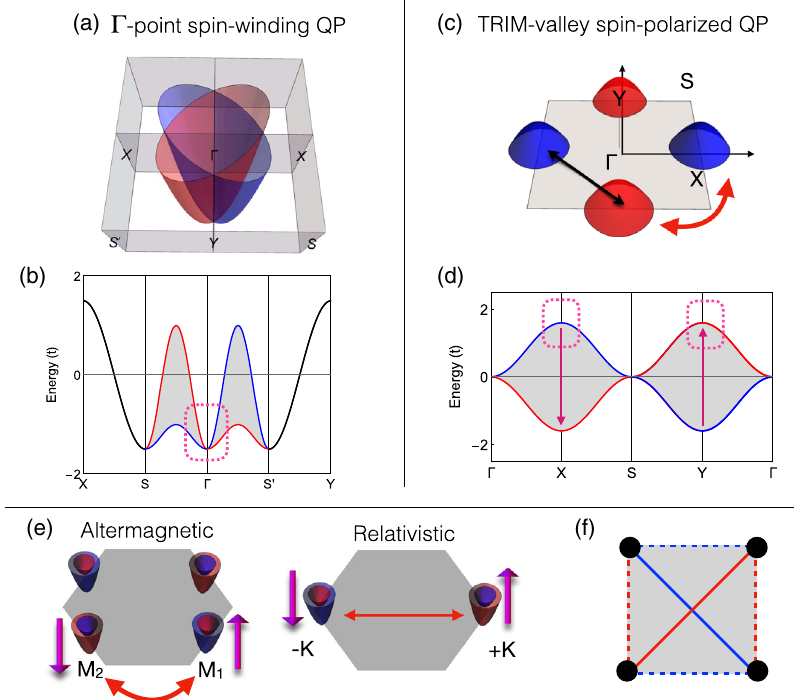
FIG. 11. (a,b) Model of the altermagnetic quasiparticle with quadratic dispersion around the spin-degenerate Γ point, and spin- winding number 2 around the Γ point. The model corresponds to Eq. (1). (c,d) Model of the altermagnetic spin-polarized valley quasiparticle with no spin winding in the valley. The model corresponds to Eq. (2). The center of a valley is at TRIM, and the spin polarization is opposite at TRIM X and Y . (e) Schematic illustration of distinct symmetries of band structures with nonrelativistic altermagnetic and relativistic nonmagnetic valleys. (f) Real-space spin-dependent hoppings used to construct model band structures in panels (a) – (c). This figure is adapted from Refs.